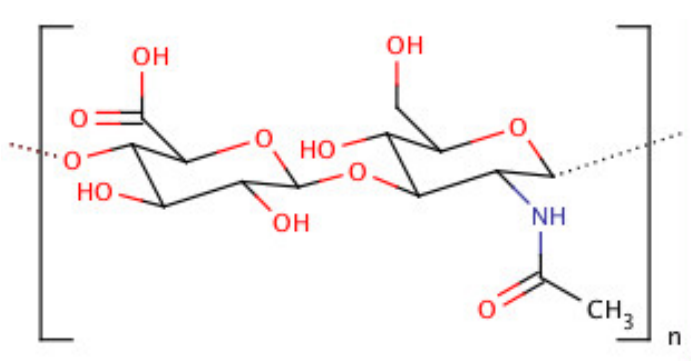
Figure 3. The structure of hyaluronic acid